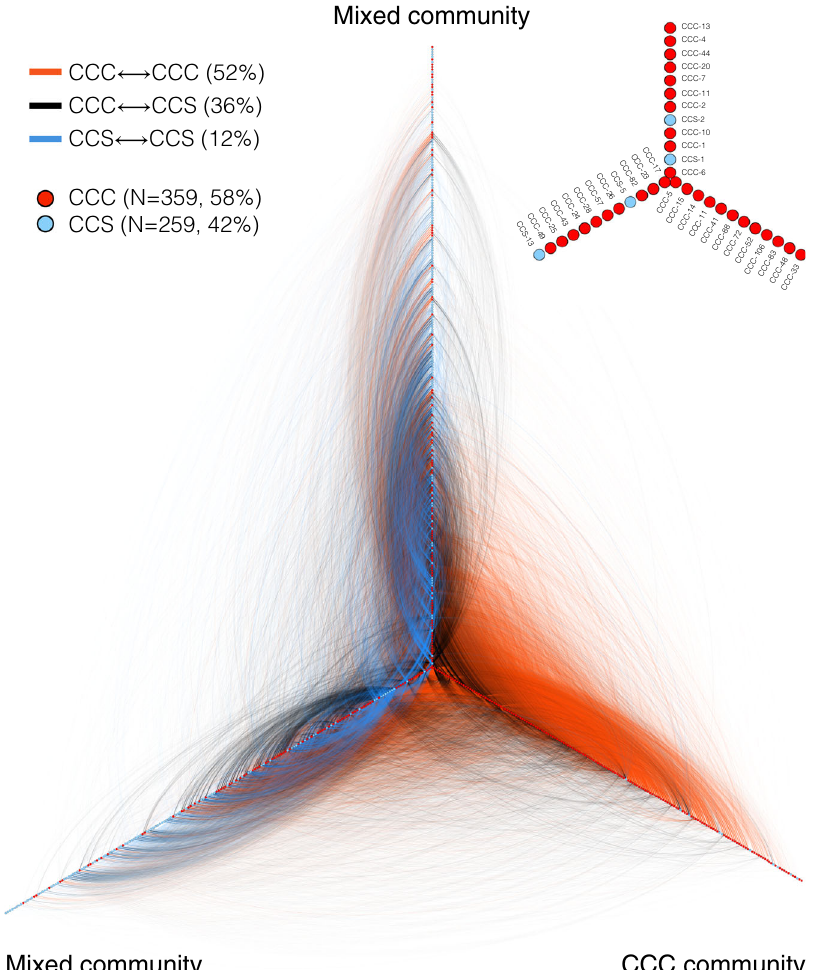
Fig. 6 Media article co-visibility network — individual level. Clustered representation of the co-visibility network: nodes are climate change contrarians (CCCs) and climate change scientists (CCSs) who have at least one media article associated with at least one other individual. Links are colored according to three types: links between members of the CCC (CCS) group are red (blue) and links between groups are black; the percentages of links by type are reported in parentheses (e.g., 52% of links are within the CCC group). We used a modularity-maximizing clustering algorithm 48 to identify three communities, with nodes ordered along each spine according to its network centrality — as such, the most prominent individuals are located at the apex. Two communities are well mixed, whereas the third represents an extremely polarized echo chamber comprised primarily of CCC. (inset) Magni fi cation of the apex showing the most prominent